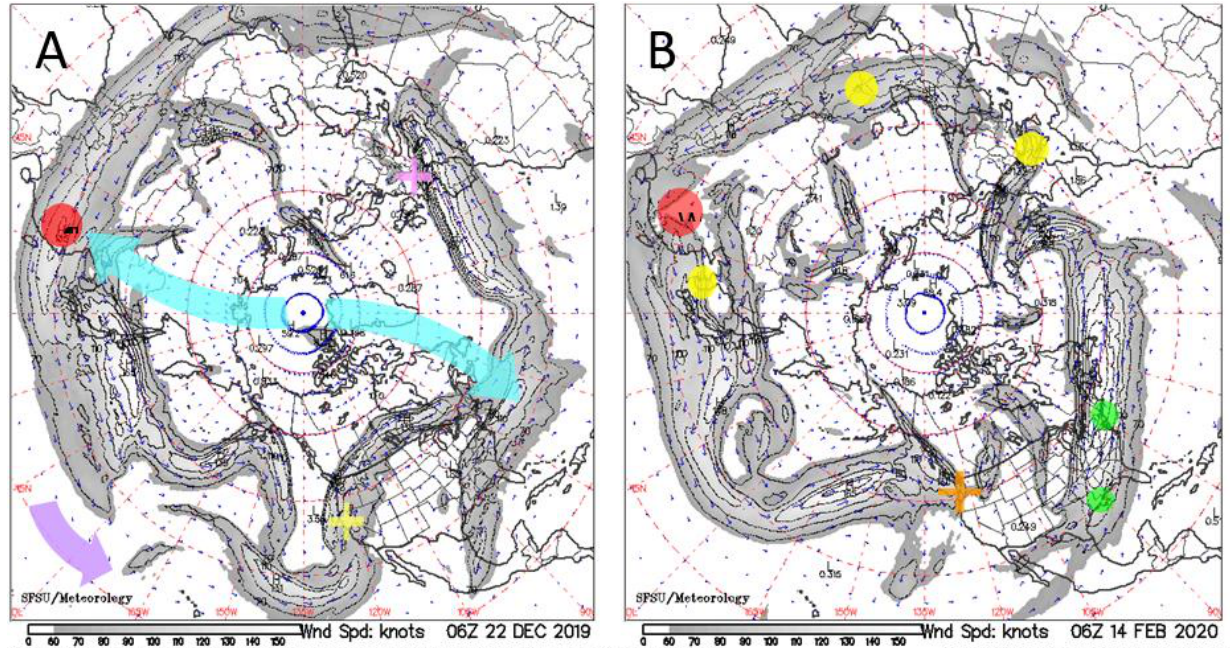
Figure 4. COVID-19 onsets [46,74] compared to NH Jet stream behavior. Maps from California Regional weather server [78]: ( A ) 22 December 2019. Red dot = Wuhan, China. Purple arrow = W to E flow of Jet stream meanders and winds. Blue arrows = sketch of surface winds in the Polar cell, which flow South and slightly West according to the Coriolis effect, rise under the Jet stream, return North near the top of the troposphere, and sink at the Pole. Flow towards France is consistent with discovery of a single case in December (pink cross), as rainout was into the Atlantic and likewise for the Pacific (bottom arrow), so isolated cases appeared in February in the US (yellow cross); ( B ) 14 February 2020. Yellow dots mark Italy, Iran, and Korea, which gained substantial cases in February. Green ovals mark New York City (under strong winds) and New Orleans with climbs in early March. Orange cross marks 37 deaths in February in a Seattle, WA nursing home.